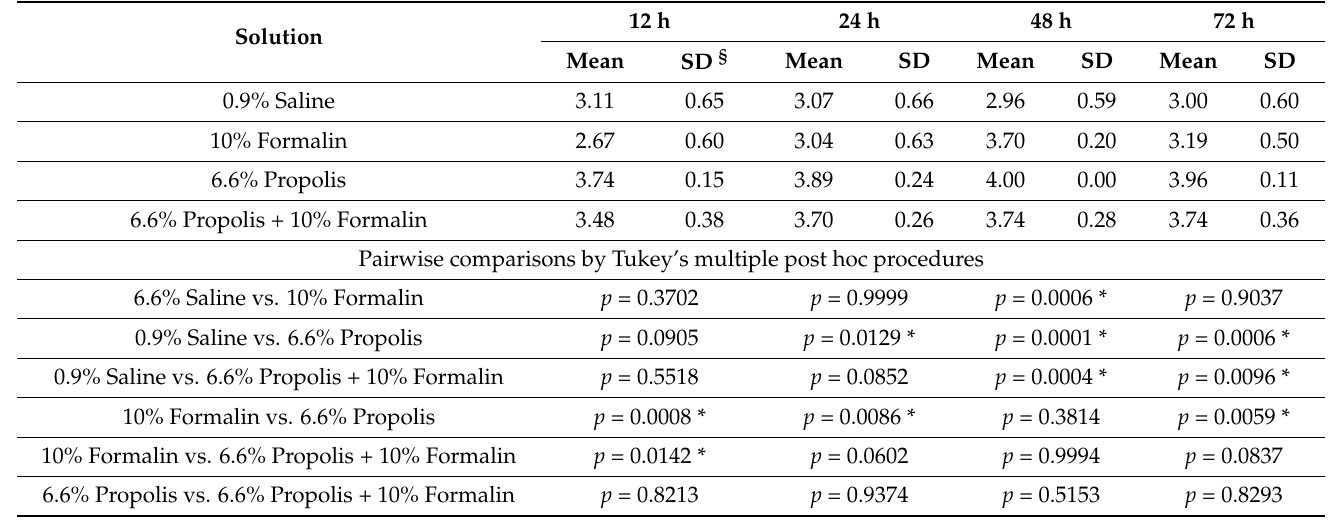
Table 3. Comparison of the fixative ability of different solutions at different treatment